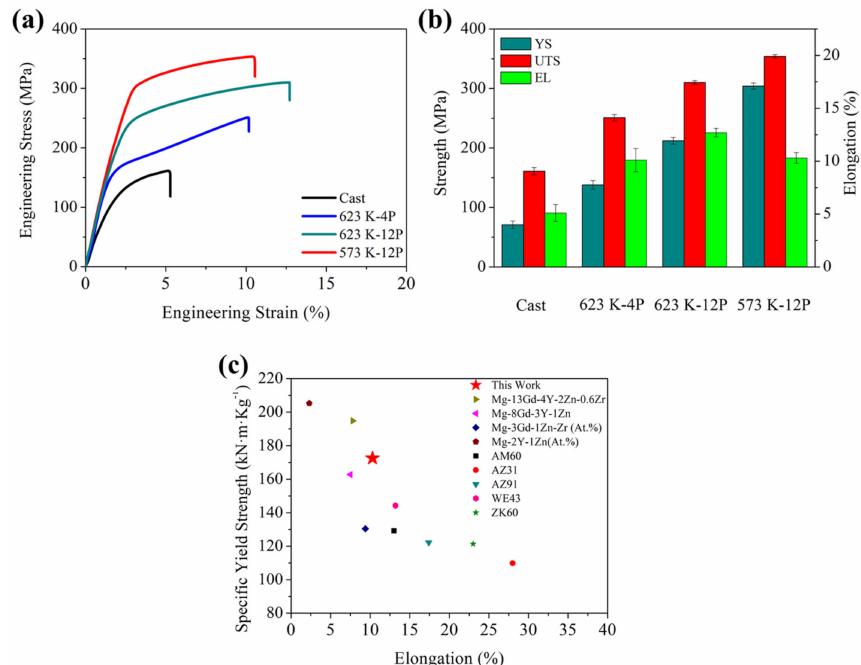
Figure 12. Mechanical properties of Mg-Al-Ca-Mn alloys. ( a ) Typical tensile curves of as-cast and ECAP alloys; ( b ) The summary of yield strength (YS), ultimate tensile strength (UTS) and elongation of various alloys; ( c ) Comparison of specific yield strength and elongation between this work and other high performance ECAP Mg alloys [27–32,37–39].